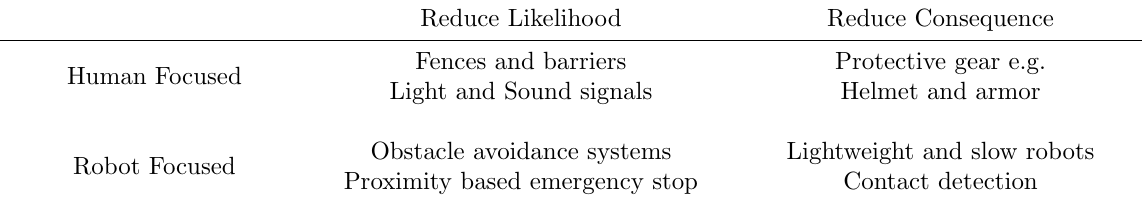
Table 1: Risk Reducing Measures for Robotic